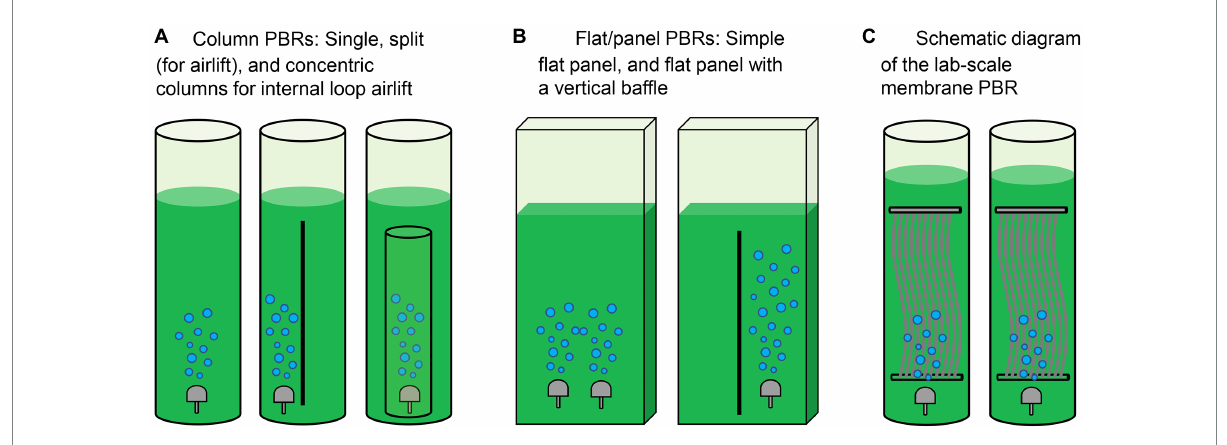
FIGURE 3 Architectures of photobioreactors (PBRs) for microalgae cultivation. (A) Column PBRs, (B) flat/panel PBRs, and (C) membrane PBR (MPBR). Refer to the study by Pawar (2016).